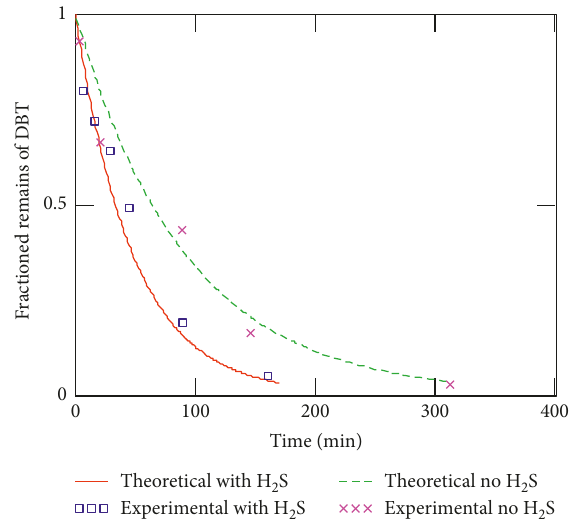
Figure 3: Pseudo-first-order plots for the HDS reactions of DBT over the C-ATS-I catalyst in the absence and presence of H 2 S.